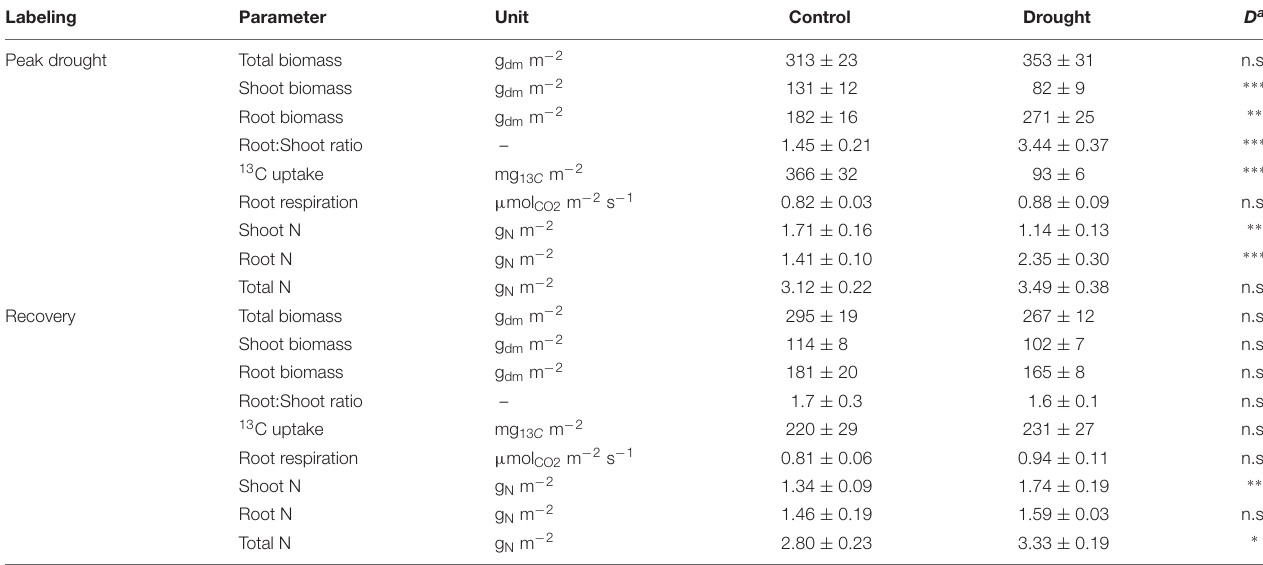
TABLE 1 | Drought effects on biomass, 13 C tracer uptake, root respiration and biomass N contents.